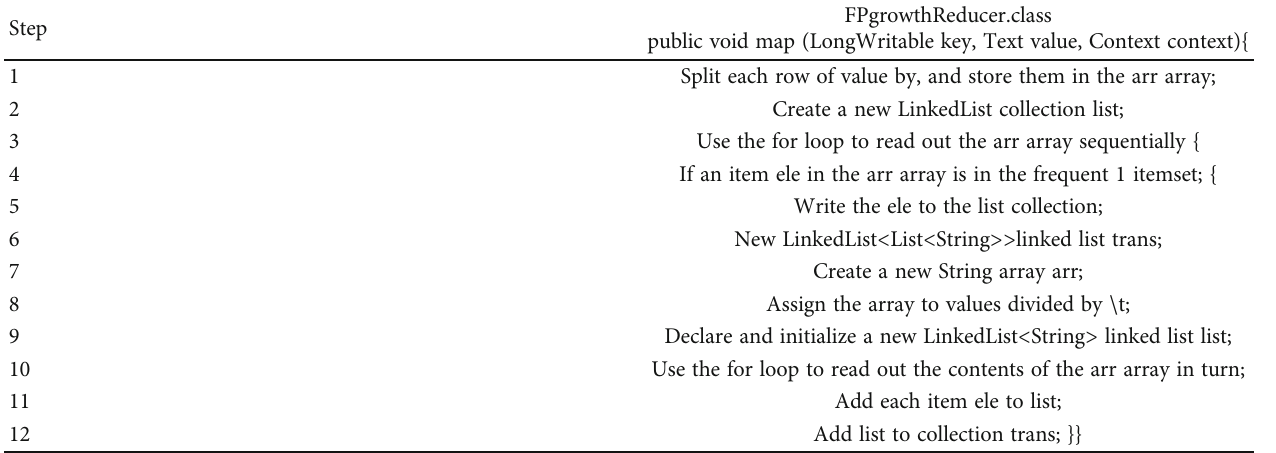
Table 4: Pseudocode of Reduce function in association rule mining